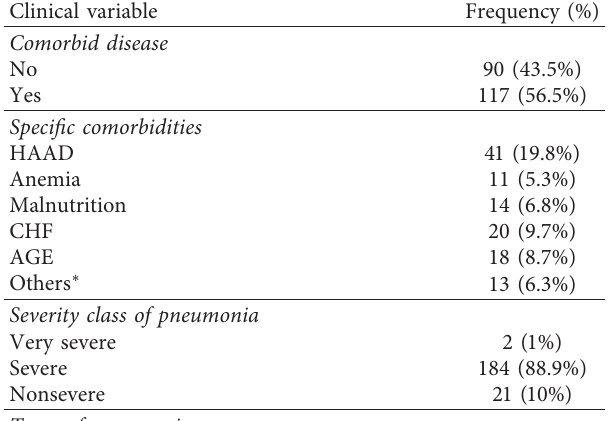
Table 2: Clinical characteristics of the study participants admitted with pneumonia in pediatric ward of Tikur Anbessa Specialized Hospital from February 2017 to February 2018, Addis Ababa, Ethiopia. Clinical